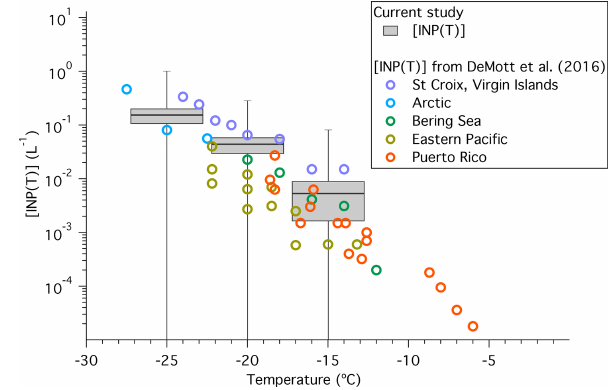
Figure 3. Plot of [INP( T )] (L − 1 ) as a function of temperature in- cluding a comparison to discrete field measurements from several recent field studies in marine environments reported in DeMott et al. (2016). The grey boxes represent the average [INP( T )] reported in this study as well as the standard error of the mean at − 15, − 20, and − 25 ◦ C. The whiskers represent the minima and maxima val- ues of [INP( T )] measured in the current study. Note the minimum [INP( T )] measured for all temperatures in the current study was zero. Other coloured circles represent INP measurements from field studies in marine environments reported in DeMott et al. (2016), with the locations indicated in the